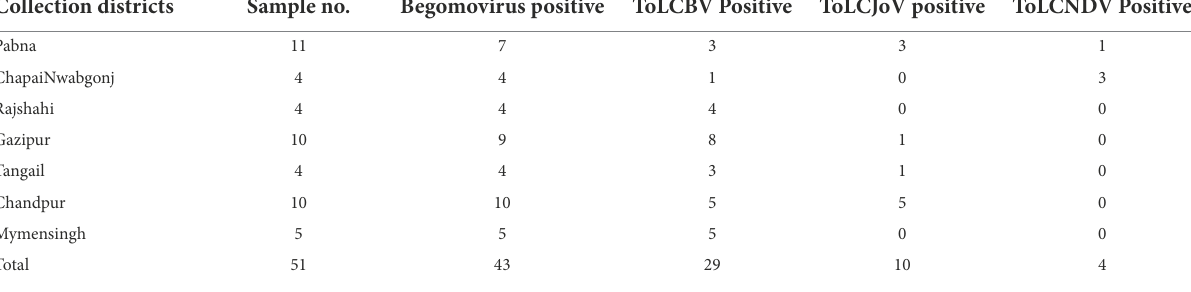
ToLCBV: Tomato leaf curl Bangladesh virus. ToLCJoV: Tomato leaf curl Joydebpur virus. ToLCNDV: Tomato leaf curl New Delhi virus.